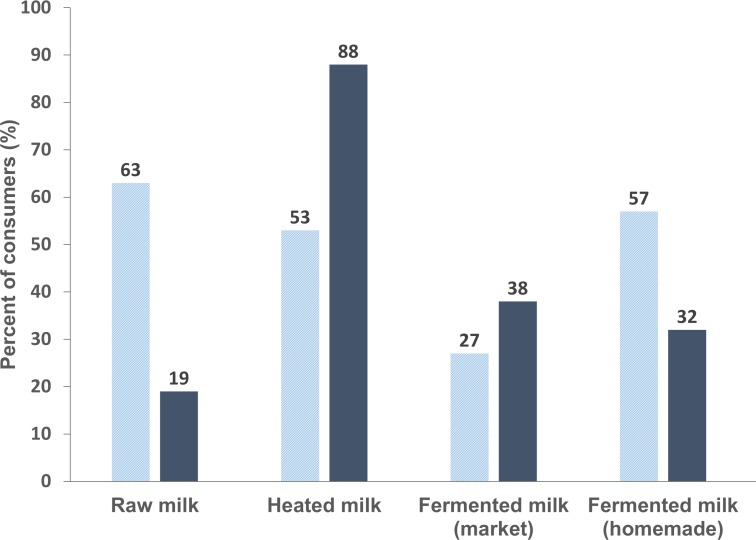
Proportion of different local dairy products consumed in farms (light colored columns) in comparison to urban households (dark columns).